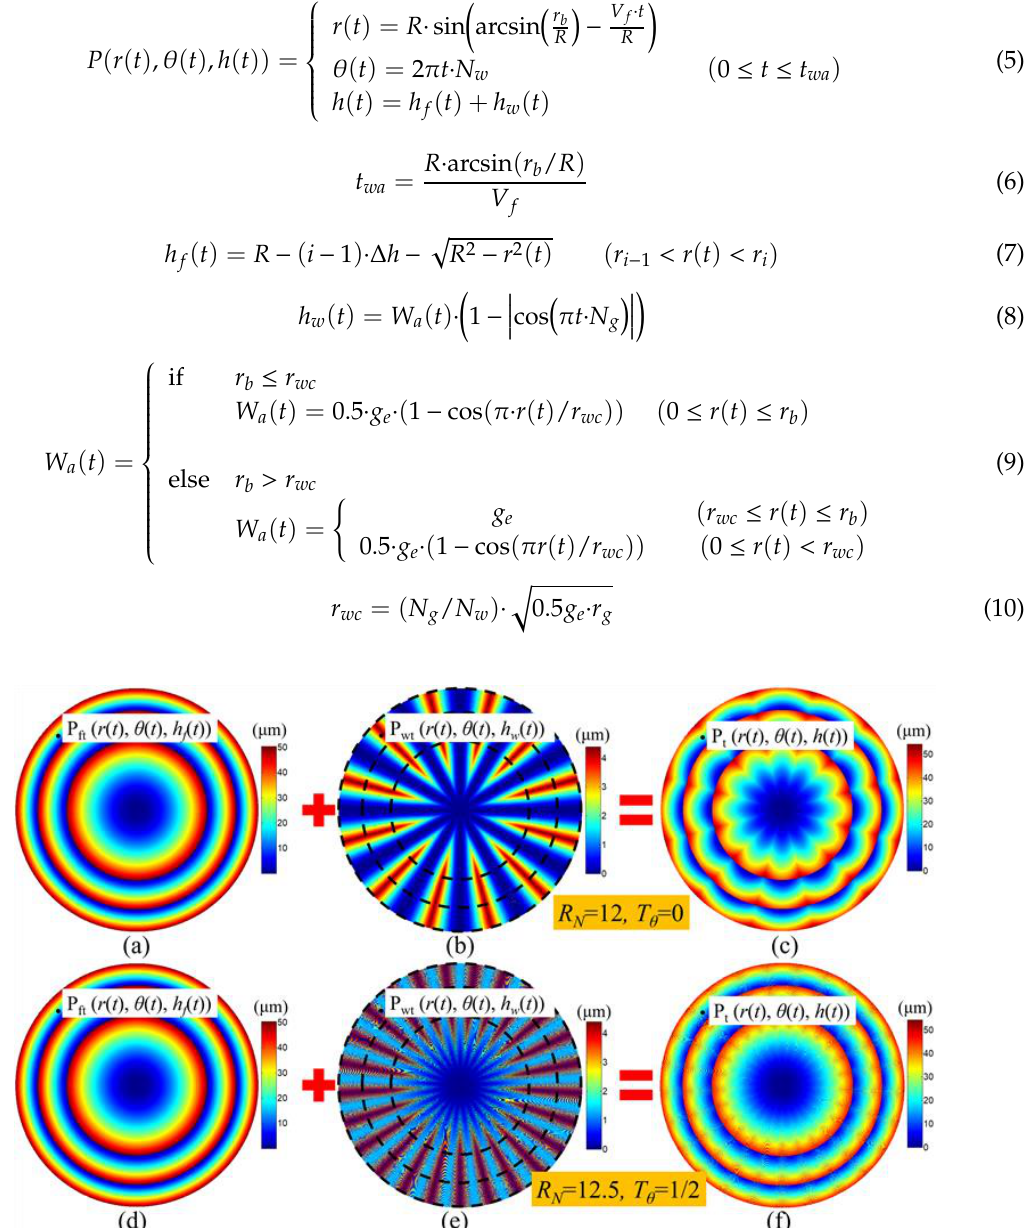
Figure 6. Simulation model of the surface waviness topography of the ground Fresnel micro-structured mold: ( a , d ) the ideal 3D model of the Fresnel mold; ( b , e ) the surface waviness model; ( c , f ) the 3D surface waviness topography of the Fresnel micro-structured mold.